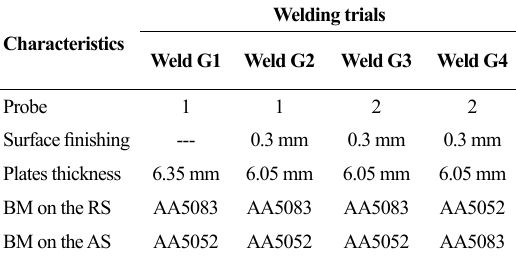
Table 3. Overview of friction stir welding experiments.